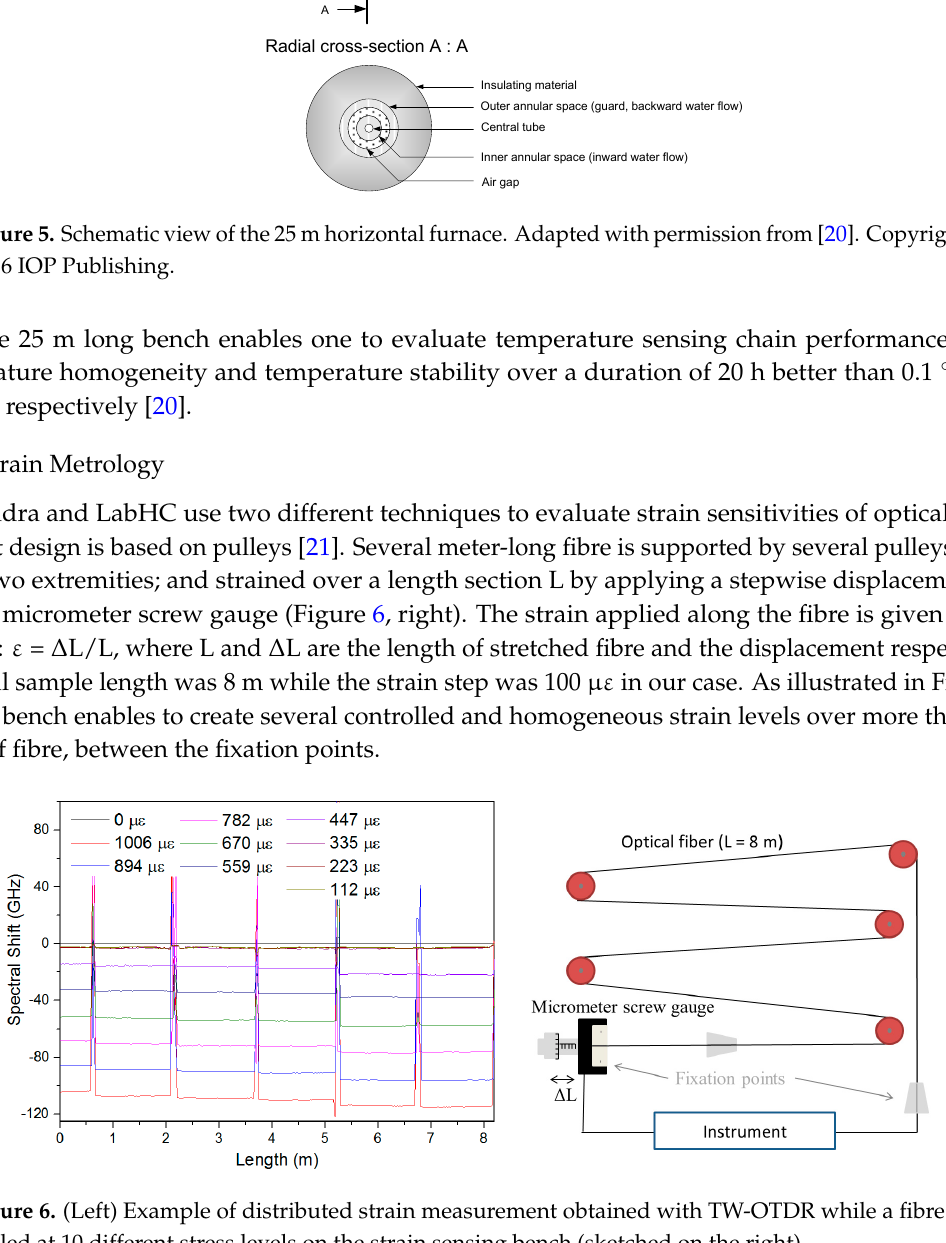
8 of 32 Figure 4. (Left) Picture of a one-to-one scale mock-up of dyke where several strain sensing cables (whose zooms are provided on the right) were tested. 3.5. Strain and Temperature Metrological Benches Several metrological benches were developed in order to impose controlled solicitation on optical fibre samples with several meter lengths (longer than the 1 m spatial resolution of most optoelectronic devices). 3.5.1. Temperature Metrology In collaboration with Andra and EDF, the Laboratoire National d’Essai (LNE, in Trappes near Paris, France) has built a dedicated facility in order to evaluate and to qualify distributed temperature sensing chains. Spatial resolution of the instrument is typically 1 m; the furnace had thus to be longer than 10 m for ensuring a spatially resolved measurement. As described in extended details in [20] and sketched in Figure 5, the horizontal furnace has a tubular configuration arranged as an assembly